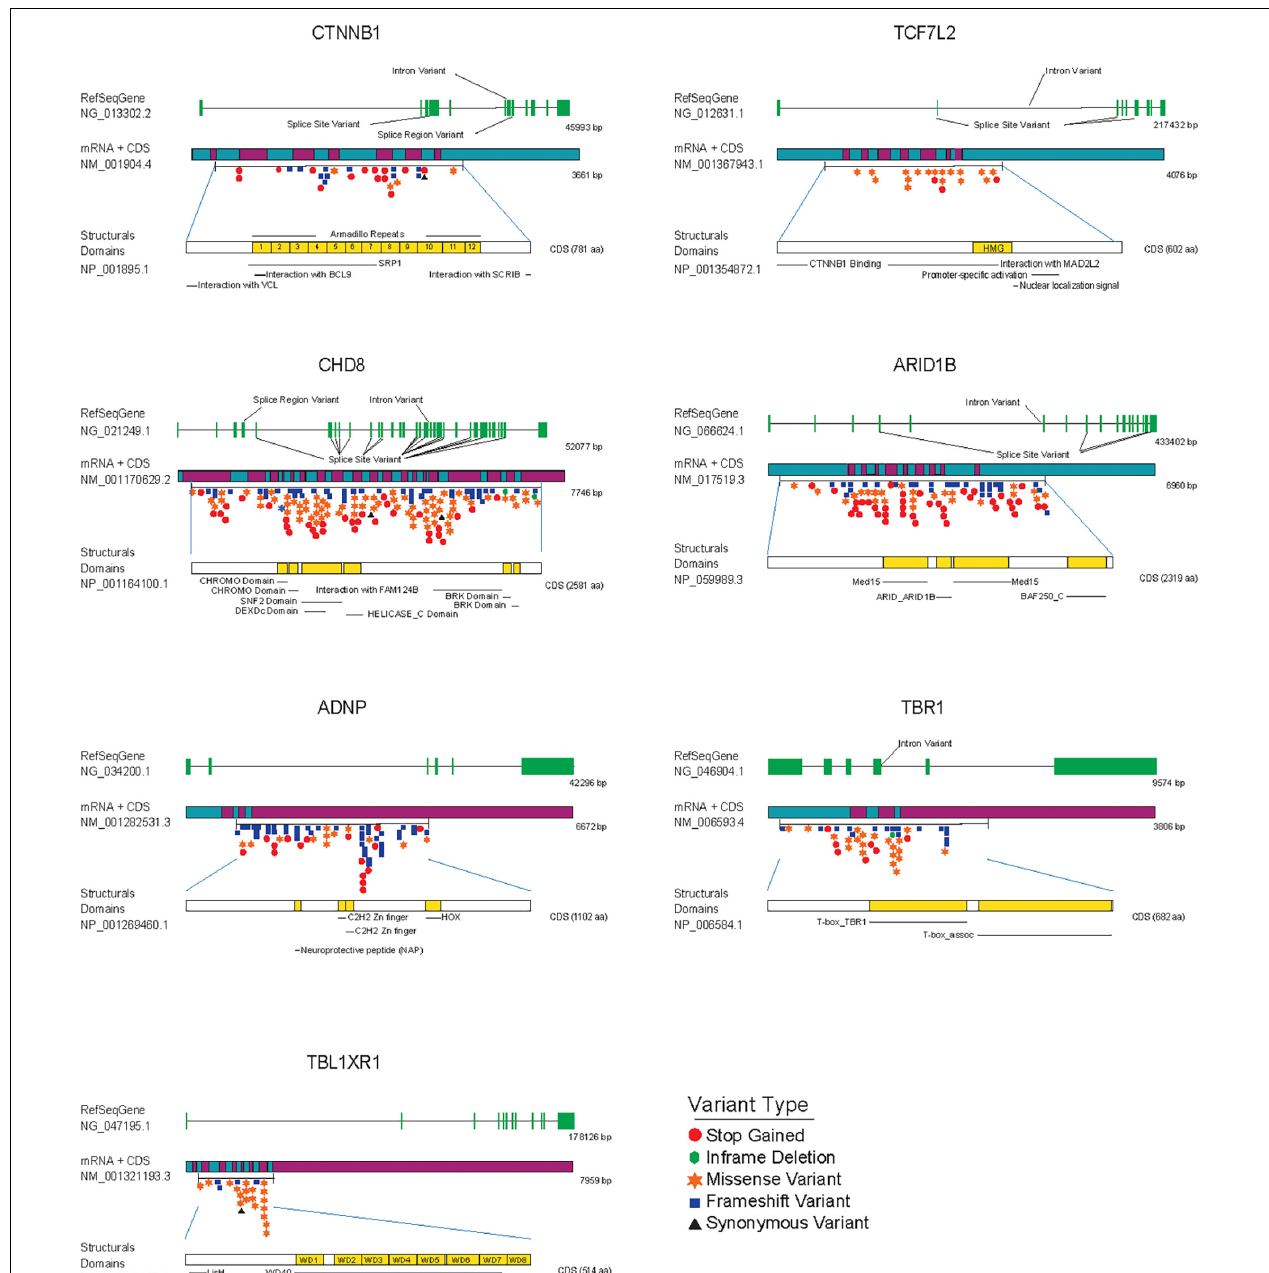
FIGURE 3 | ASD de novo mutations in SFARI gene database associated with transcriptional components and chromatin remodeling factors modulating Wnt/ β -catenin signaling. From top to bottom each figure shows: the reference gene used to identify mutations (RefSeqGene) with exons colored in green, the mRNA associated with the gene decorated with de novo mutations with the start and end of the coding sequence (CDS), and structural domains of each protein colored in yellow, as a reference to the importance of each mutation regarding structure and operation in general. Variants are highlighted and colored according to the Variant Type